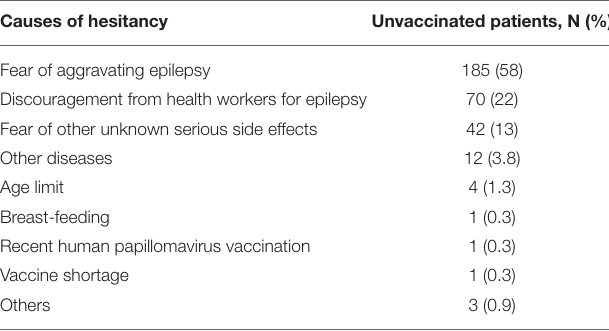
TABLE 2 | Predominant concerns about the COVID-19 vaccine among patients with epilepsy.